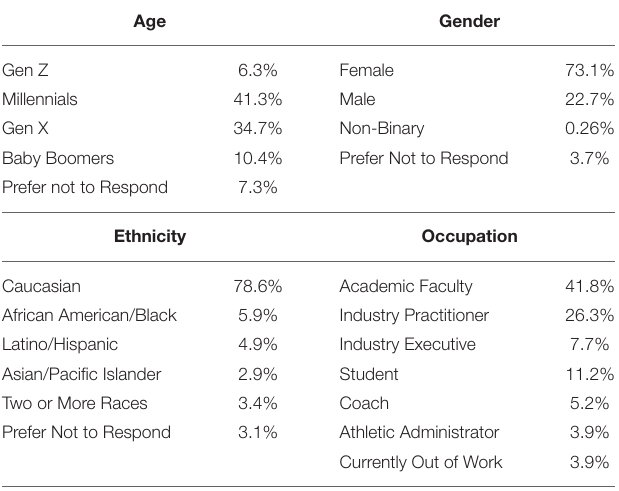
TABLE 1 | Demographic characteristics of